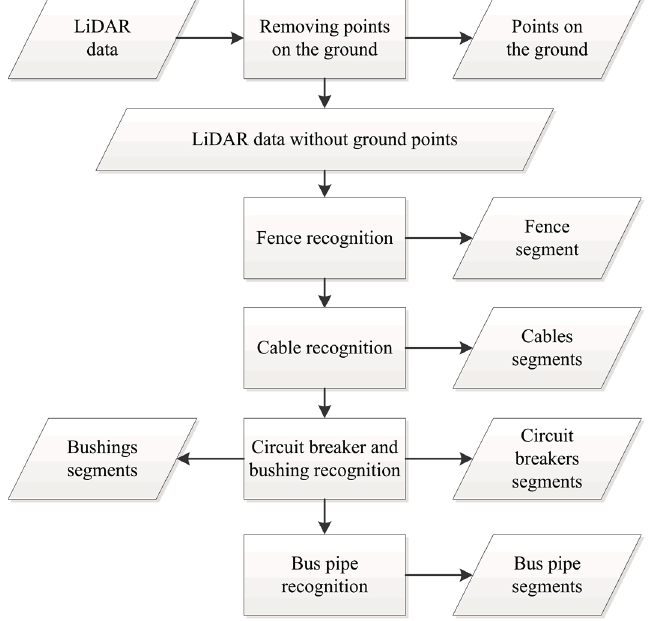
Figure 2. Flowchart of the entire